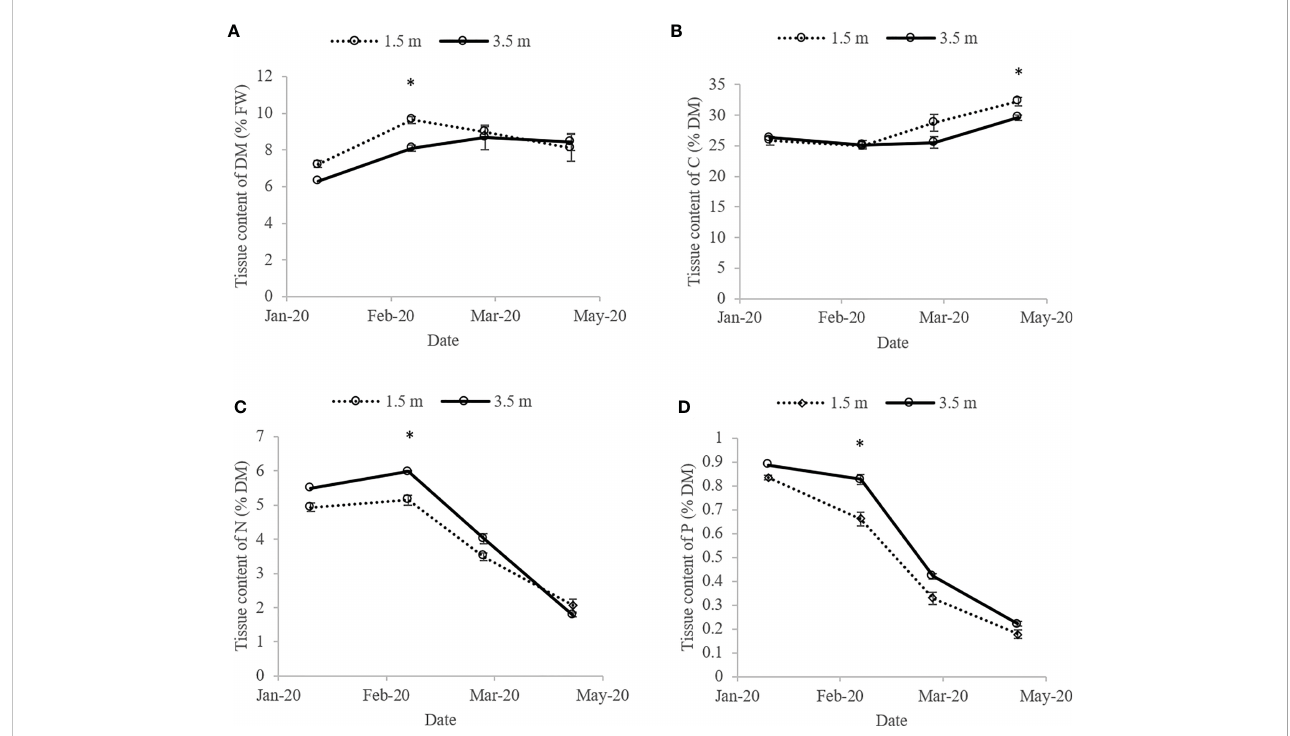
FIGURE 7 Composition of S. latissima from 1.5 and 3.5 m cultivation depth: (A) DM (% of FW), (B) C (% of DM), (C) N (% of DM) and (D) P (% of DM) contents from the horizontal layer cultivation system. * mark signi fi cant differences between biomass cultivated at different depths. Data are shown as average ± SE. n = 1 in January at 3.5 meters depth, otherwise n = 3.